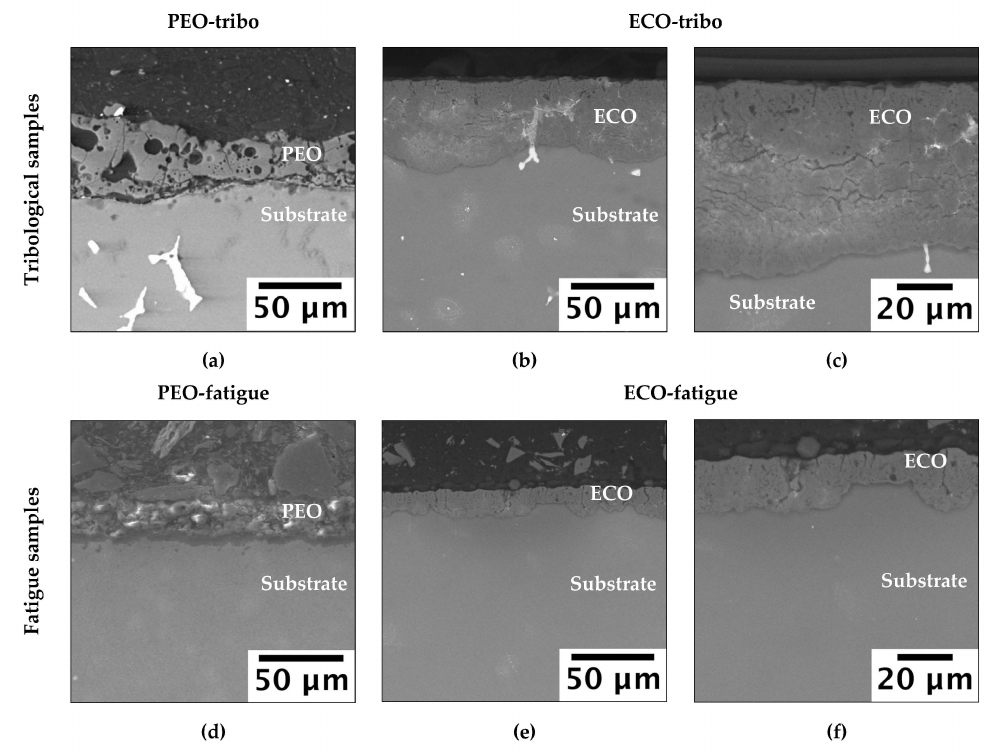
Figure 3. Polished cross sections (BSE images) of the anodic layers on cast EV31A-T6: PEO ( a , d ) and ECO layers ( b , c , e , f ) on samples for tribological ( a – c ) and fatigue ( d – f ) testing. BSE images in Figure 3b,c and elemental X-ray maps recorded by EDS on polished cross sections (Figure 4) evidenced the incorporation of the Nd- and Gd-rich